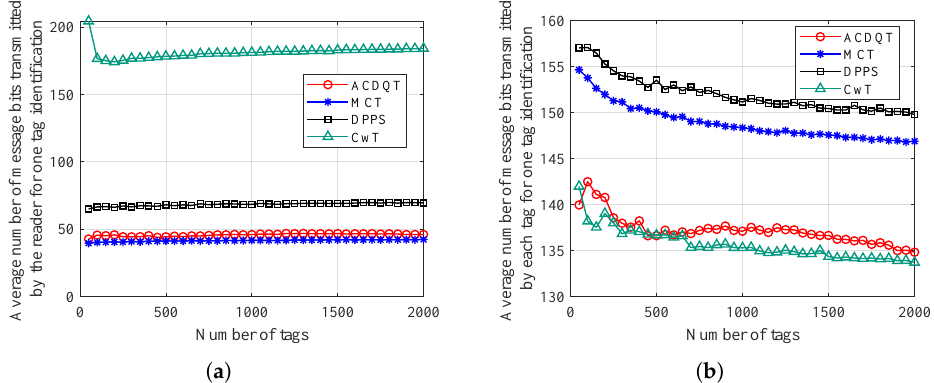
Figure 9. Average number of message bits needed for one tag identification: ( a ) on the the reader side; ( b ) on the tag